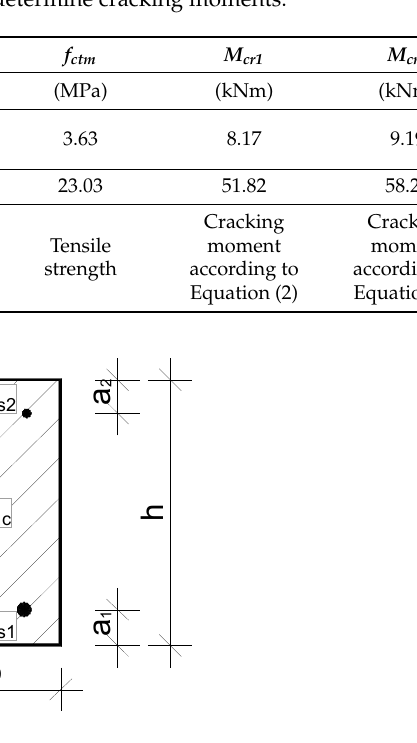
Table 8. The results of calculations performed to determine cracking moments.